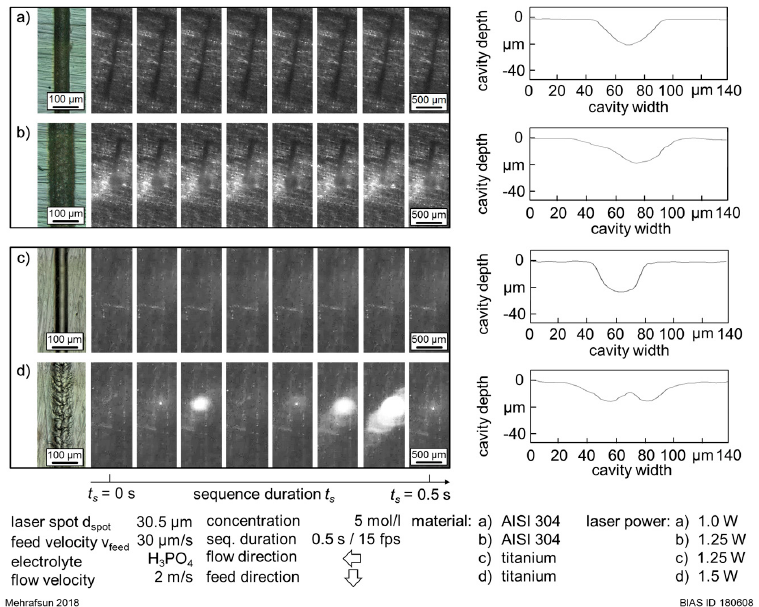
Figure 7. CCD snapshots of the LCM interaction zone at the transition from a disturbance ‐ free to a disturbed removal as well as the corresponding removal profiles obtained in ( a , b ) stainless steel and ( c , d ) titanium in a 5 ‐ molar phosphoric acid solution depending on the laser power at v feed = 30 μ m/s.